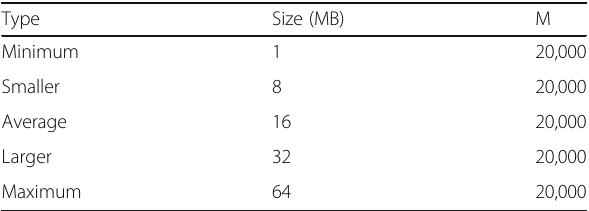
Table 1 File type and size (MB)